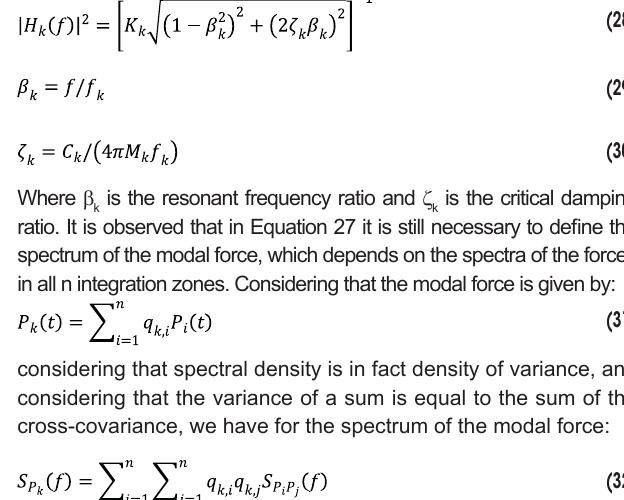
Steps in calculating the structural response